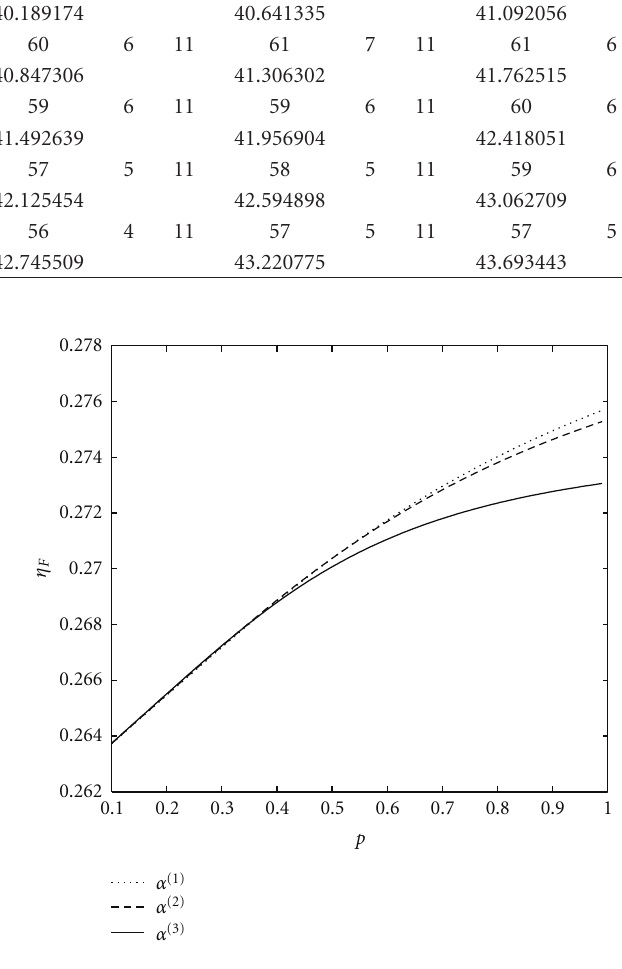
Figure 12: Fraction of time server is on vacation— p versus α ( n ) ( S = 90, s = 15, N = 25, λ = 8, β = 1 . 4, γ = 0 . 7, μ = 0 . 8 .